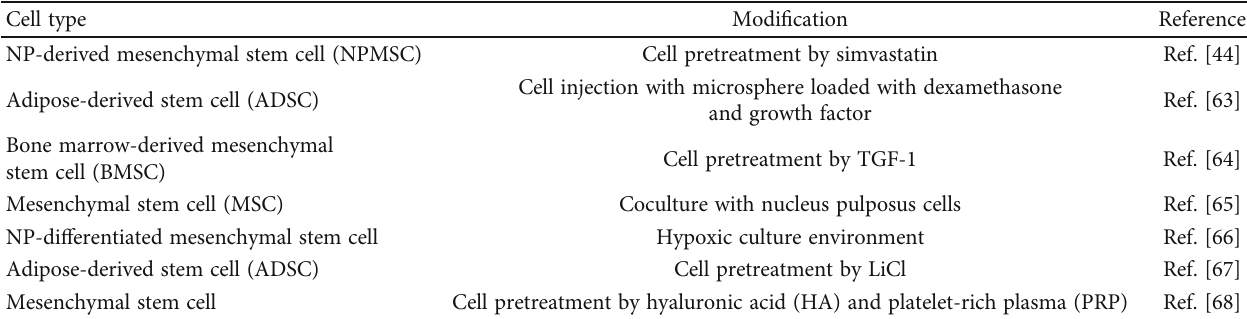
Table 2: Some examples of the modi fi cation of the cells in